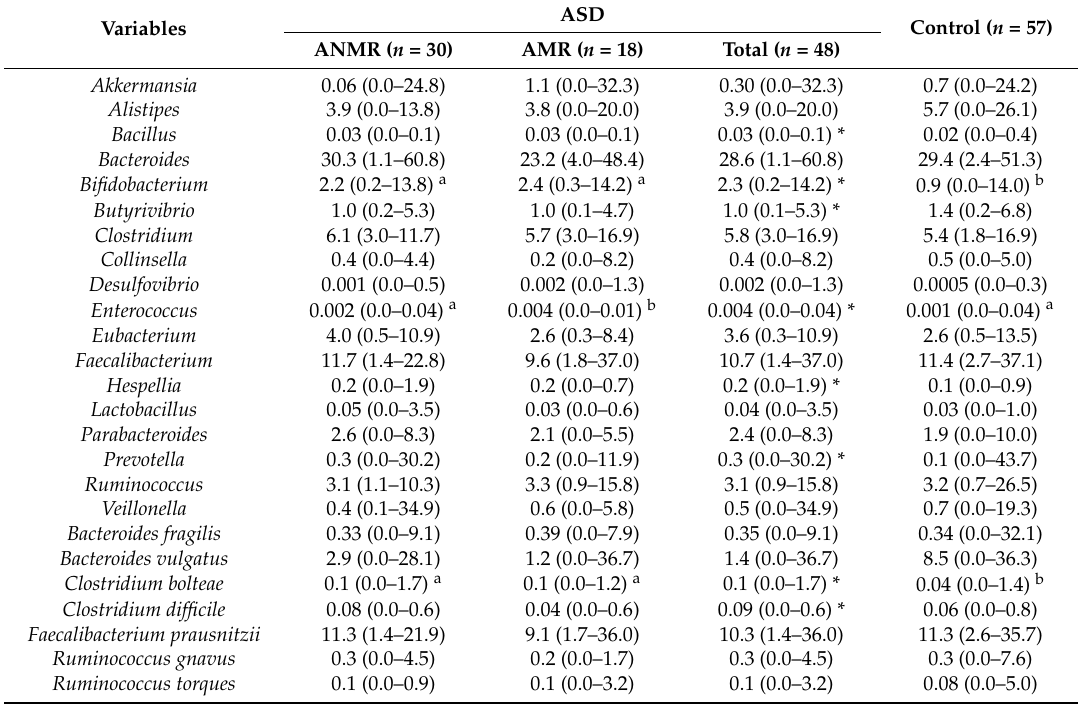
Table 3. Relative abundances of fecal bacteria (genus and species) in children with ASD classified by mental regression and healthy